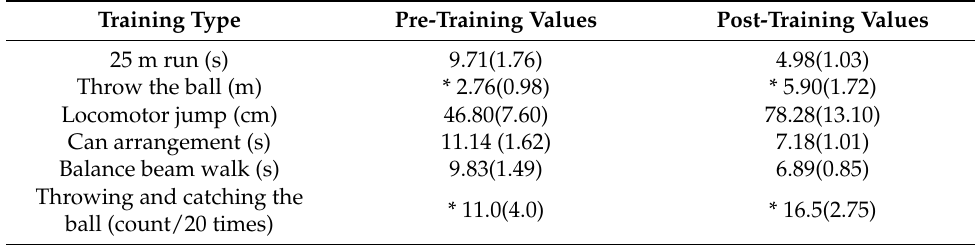
Table 3. Descriptive data per